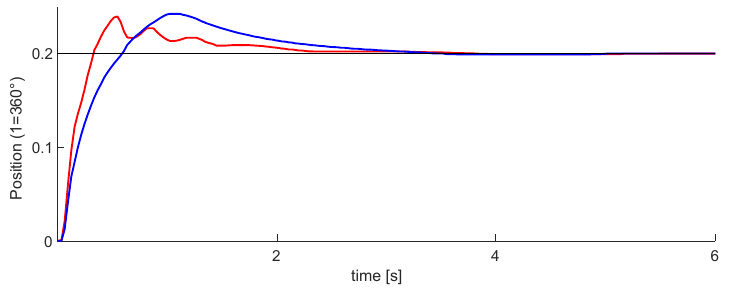
Figure 19. Experimental results for PID (blue) vs. Neuro-PID (red) controller for a DoF. Table 3. Transient response specifications of PID and Neuro-PID controllers.